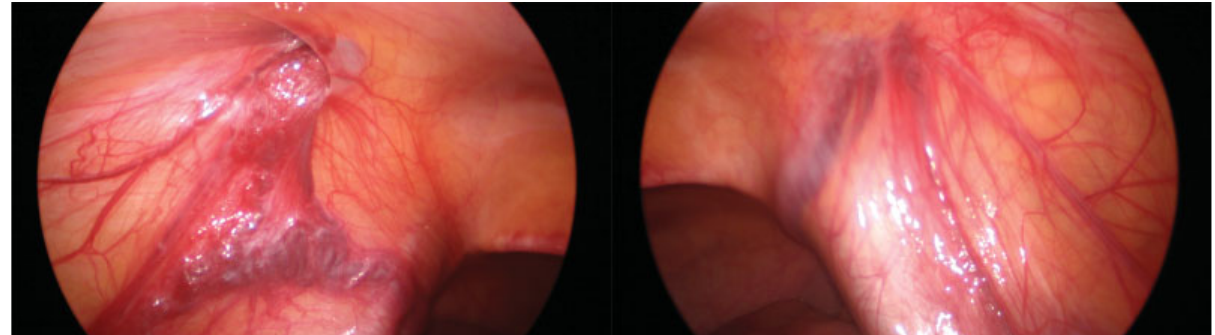
Fig. 1 Magnetic resonance imaging (MRI).